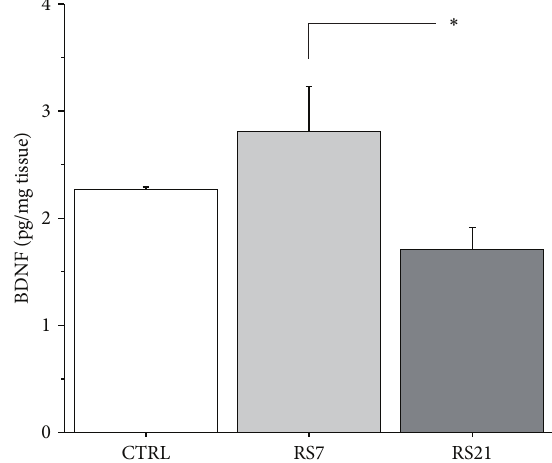
Figure 2: Effects of restraint stress on hippocampal BDNF levels. BDNF levels were decreased following a chronic 21 days restraint procedure compared to 7 days of repeated restraint. Data shown are mean + S.E.M. ∗ 𝑃 < 0.05